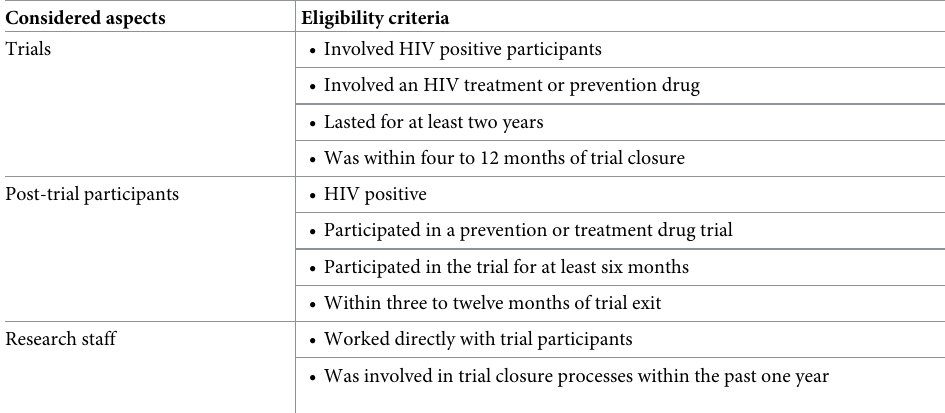
Table 2. Eligibility